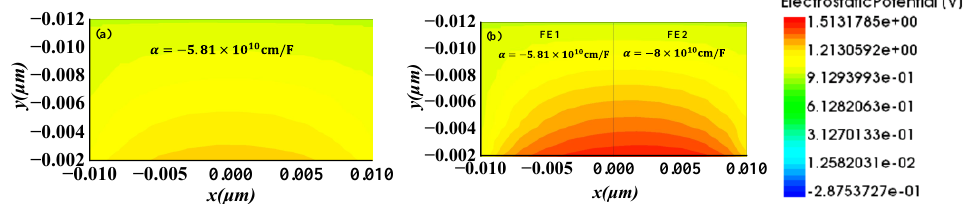
Figure 2. Potential distribution of the ferroelectric region, ( a ) conventional ferroelectric region, ( b ) dual ferroelectric region with variable α .